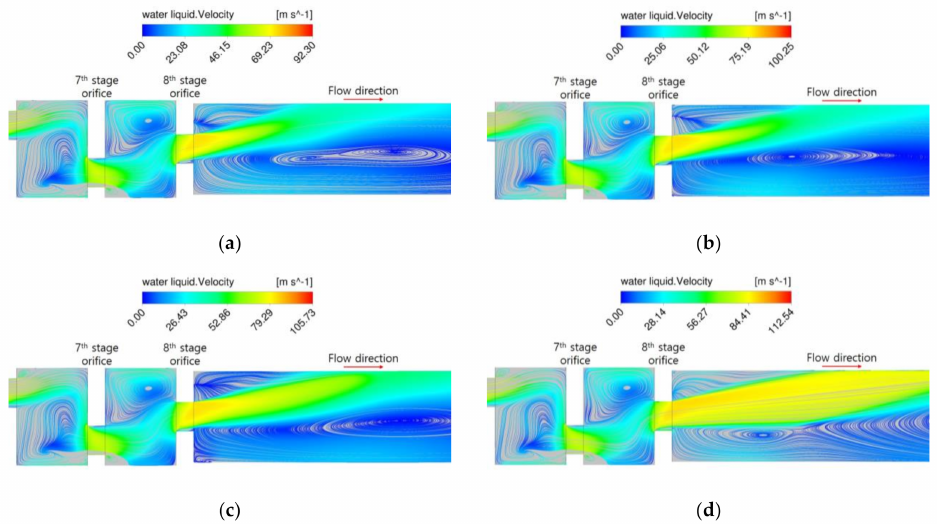
Figure 14. Distribution of flow velocity and streamlines inside the eight-stage orifice and the connect- ing pipe (for the symmetric y-z plane) depending on the operating flow rate: ( a ) Q in = 34.1 m 3 /h (Re = 2.74 × 10 5 ); ( b ) Q in = 37.0 m 3 /h (Re = 2.97 × 10 5 ); ( c ) Q in = 39.0 m 3 /h (Re = 3.13 × 10 5 );